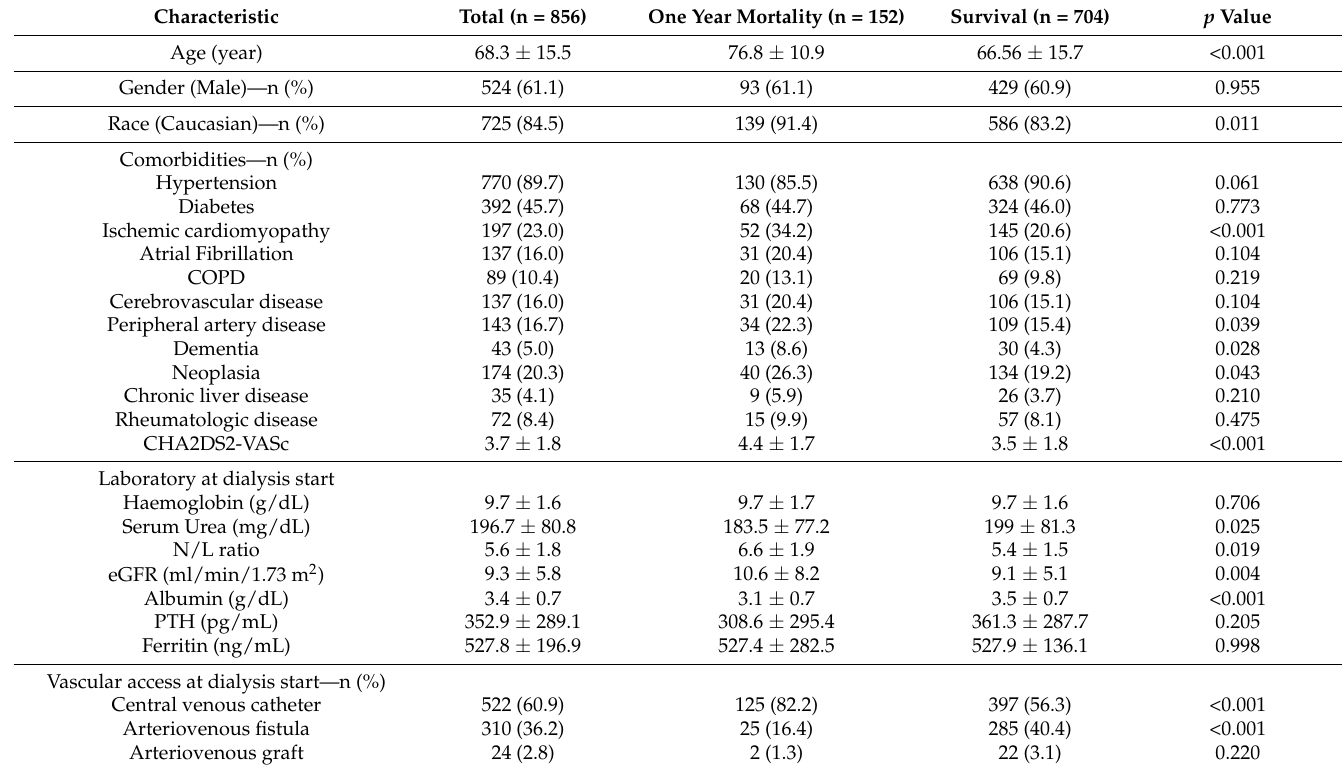
Table 1. Baseline